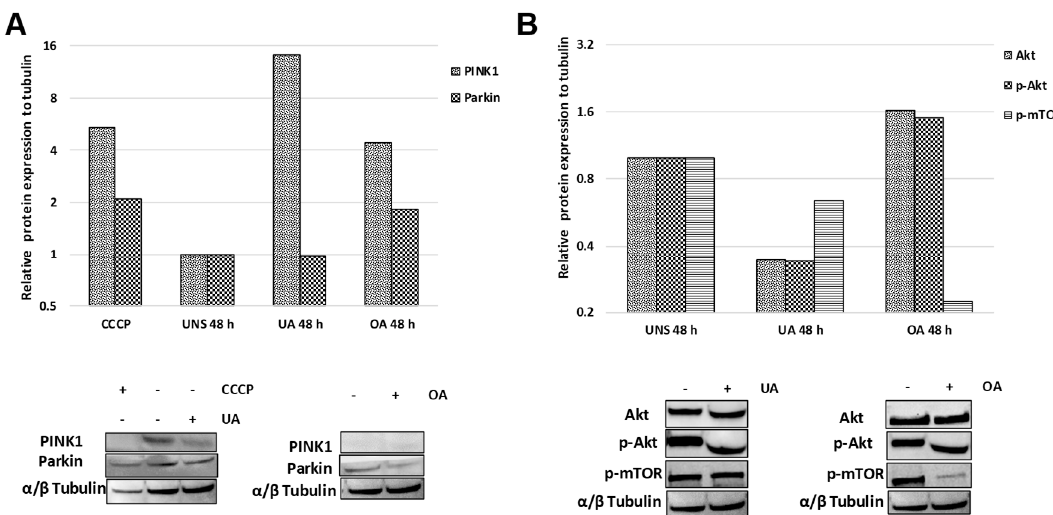
Figure 5. Ursolic and oleanolic acids trigger di ff erent signaling pathway to induce mitophagy. A549 cell monolayers were stimulated with ursolic acid (UA) or oleanolic acid (OA) during 48 h and western blot analyses were conducted. ( A ) The relative protein expression of PINK1 and Parkin in stimulated cells are shown. ( B ) The relative protein expression of Akt, p-Akt, and p-mTOR in stimulated cells are shown. The plots show the results of densitometry analyses of representative blots. CCCP was used as positive control of PINK1 and Parkin expression. Both acids were simultaneously analyzed in the same